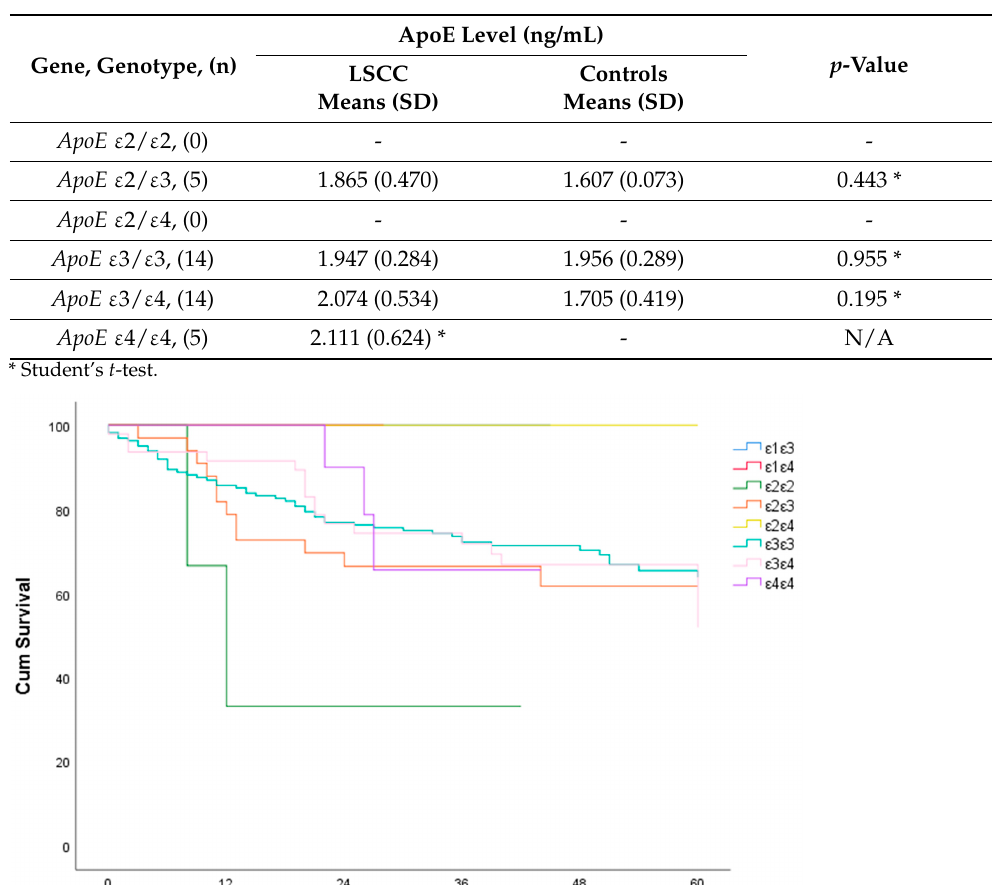
Table 12. Genotype distribution and serum ApoE levels.